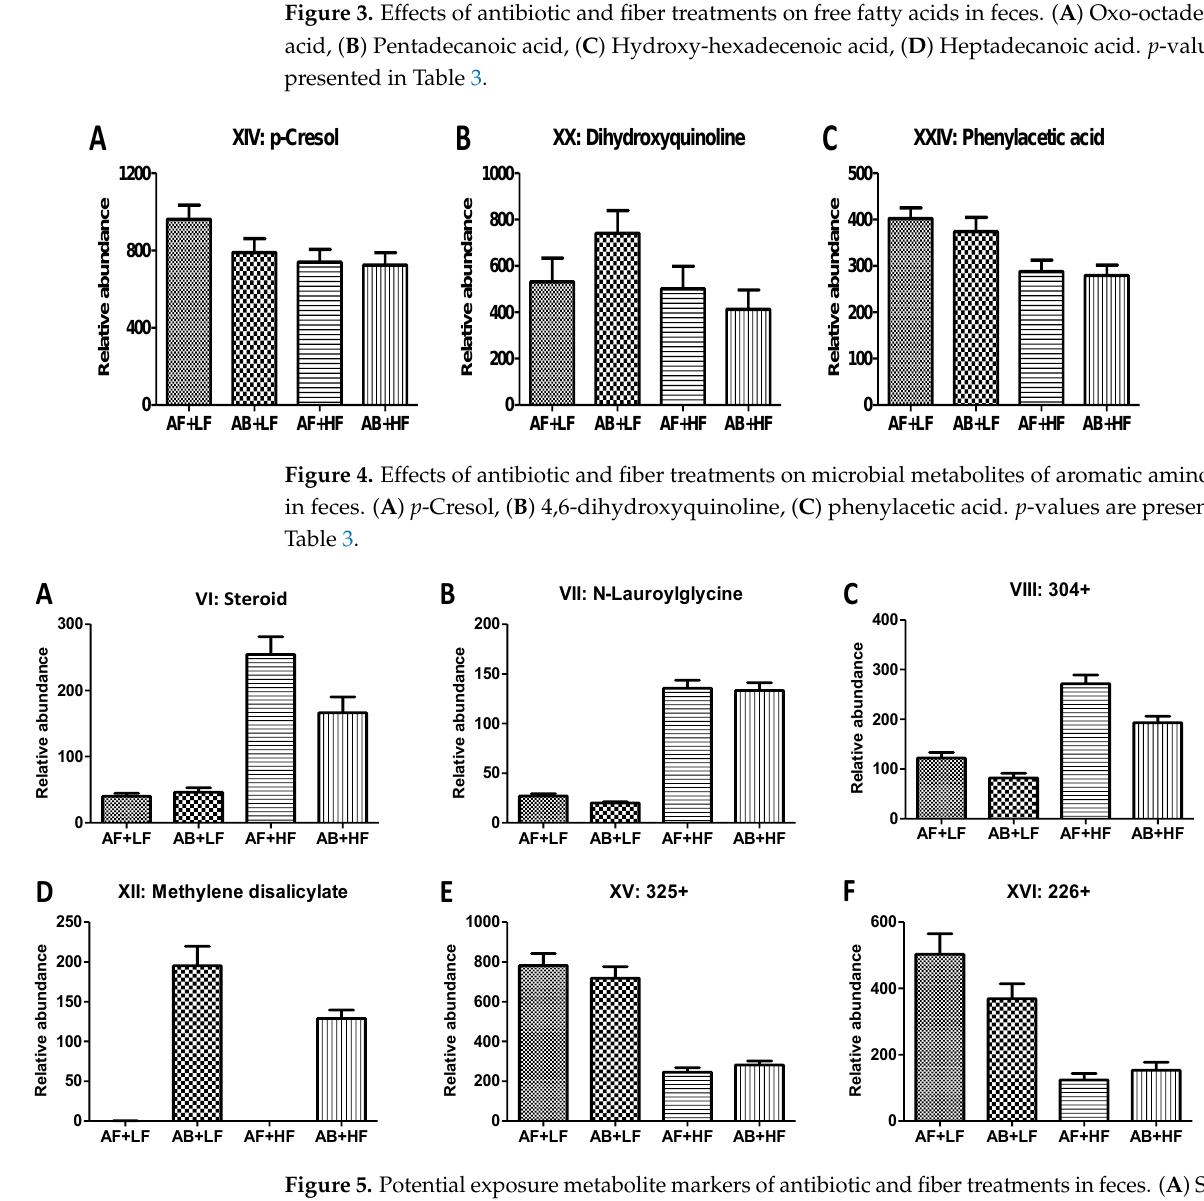
Figure 5. Potential exposure metabolite markers of antibiotic and fiber treatments in feces. ( A ) Steroid, ( B ) N -lauroylglycine, ( C ) 304+, ( D ) Methylene disalicylate, ( E ) 325+, ( F ) 226+. p -values of treatments are presented in Table 3.